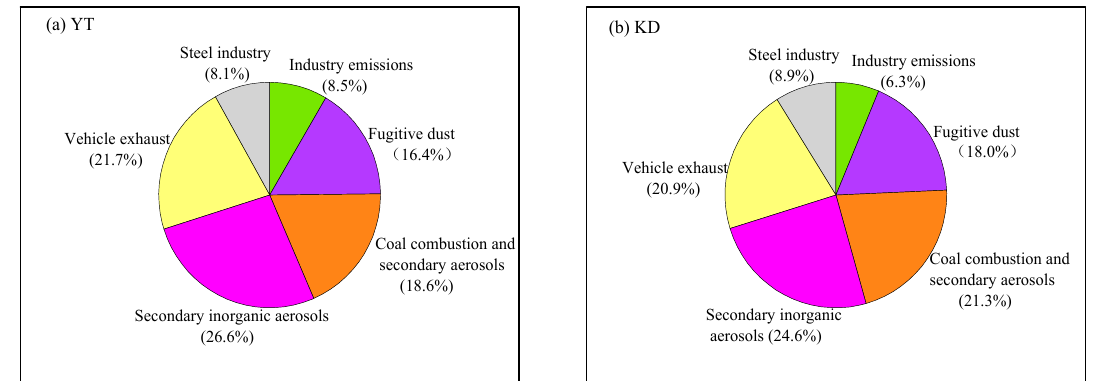
Figure 8. Contributions of different sources (factors) to PM 2.5 mass at ( a ) YT and ( b ) KD.